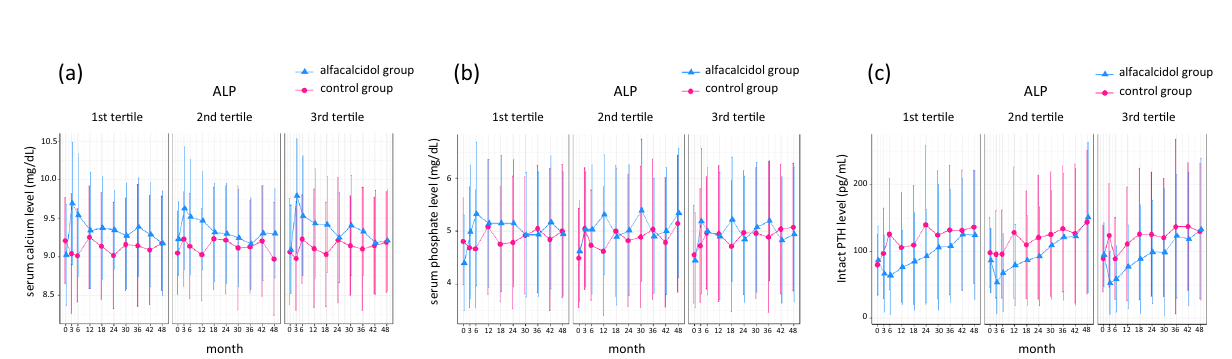
Figure 2. Time-series changes in laboratory data during 48-month study period stratified by alkaline phosphatase tertiles. ( a ) Serum corrected calcium level, ( b ) serum phosphate level, and ( c ) intact parathyroid hormone level. There are no significant effect modifications between the treatment assignment, alkaline phosphatase, and time for calcium ( P = 0.21), phosphate ( P = 0.55), and intact parathyroid hormone ( P = 0.29). )c()b()a(